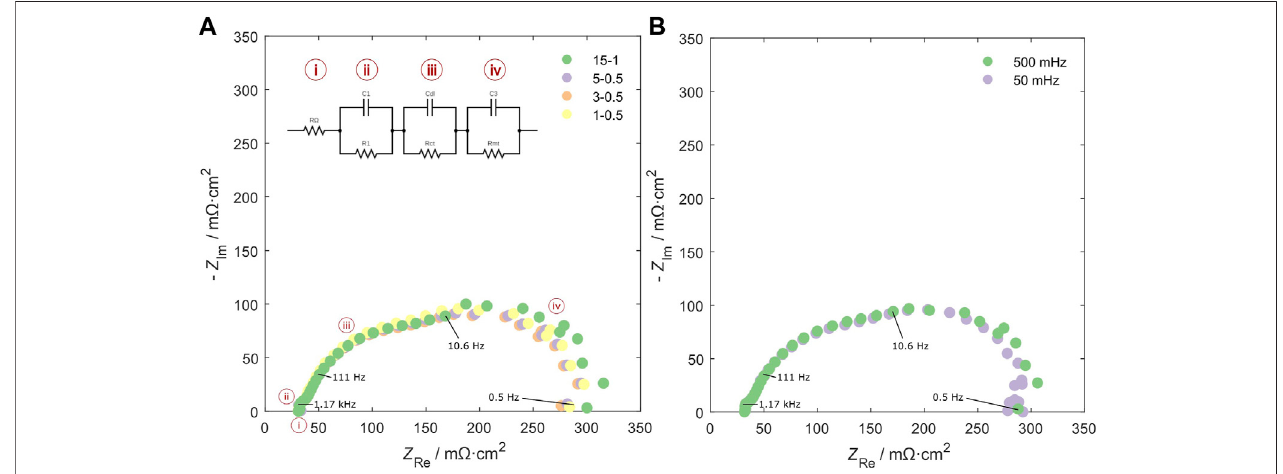
FIGURE 2 | Measured EIS spectra as a function of experimental settings; (A) varying the repeating wavelengths, N rep , and initial waiting time, N wait . Important Nyquist plot featured are identi fi ed: i) the high frequency intercept, ii) the small high-frequency loop, iii) the medium-frequency loop, and iv) the low frequency loop. (B) Measured EIS spectra as a function of minimum frequency, f min